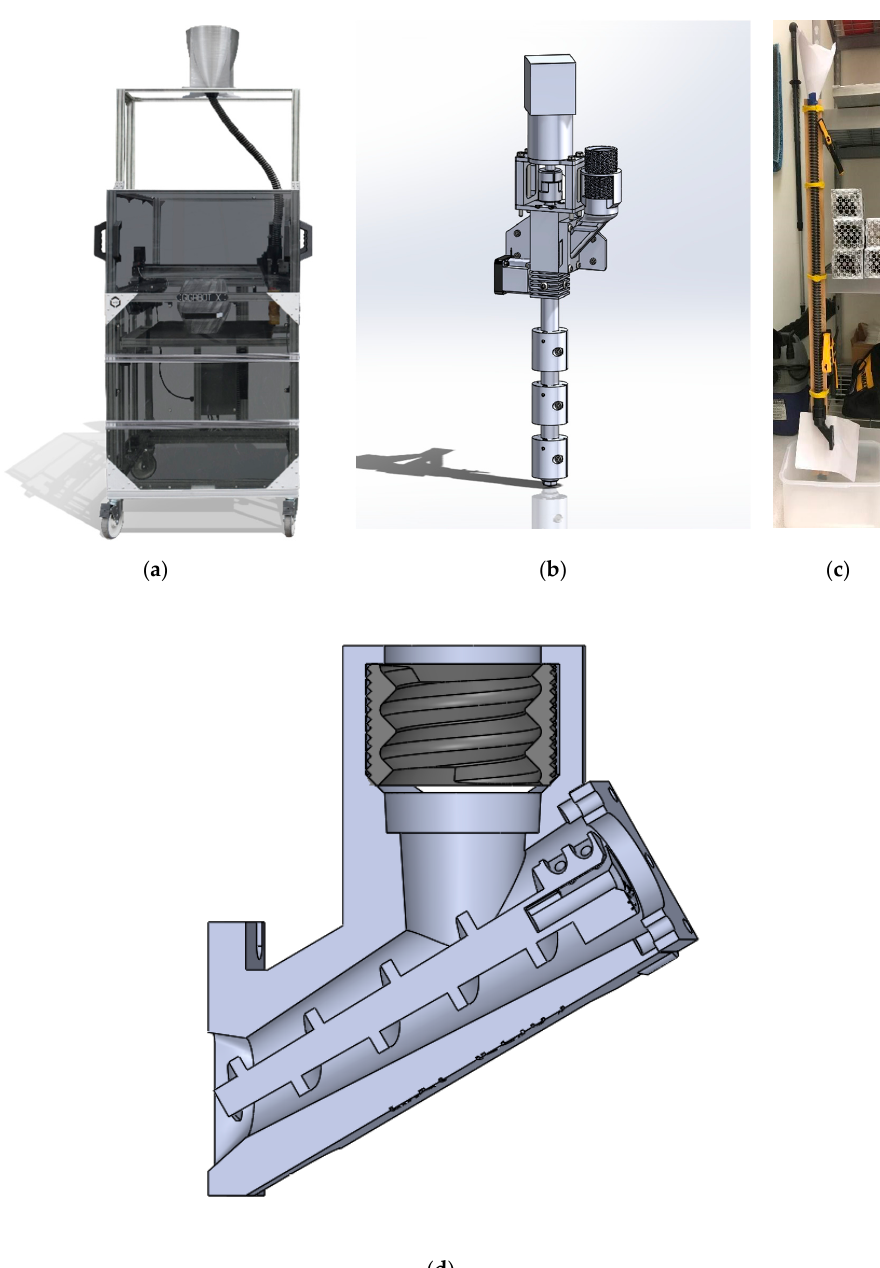
Figure 2. ( a ) Gigabot X design with feed tube, ( b ) close up of 3-heat zone extruder, ( c ) feed test apparatus and ( d ) cross-section view of the Crammer feed throat with the auger screw inside.